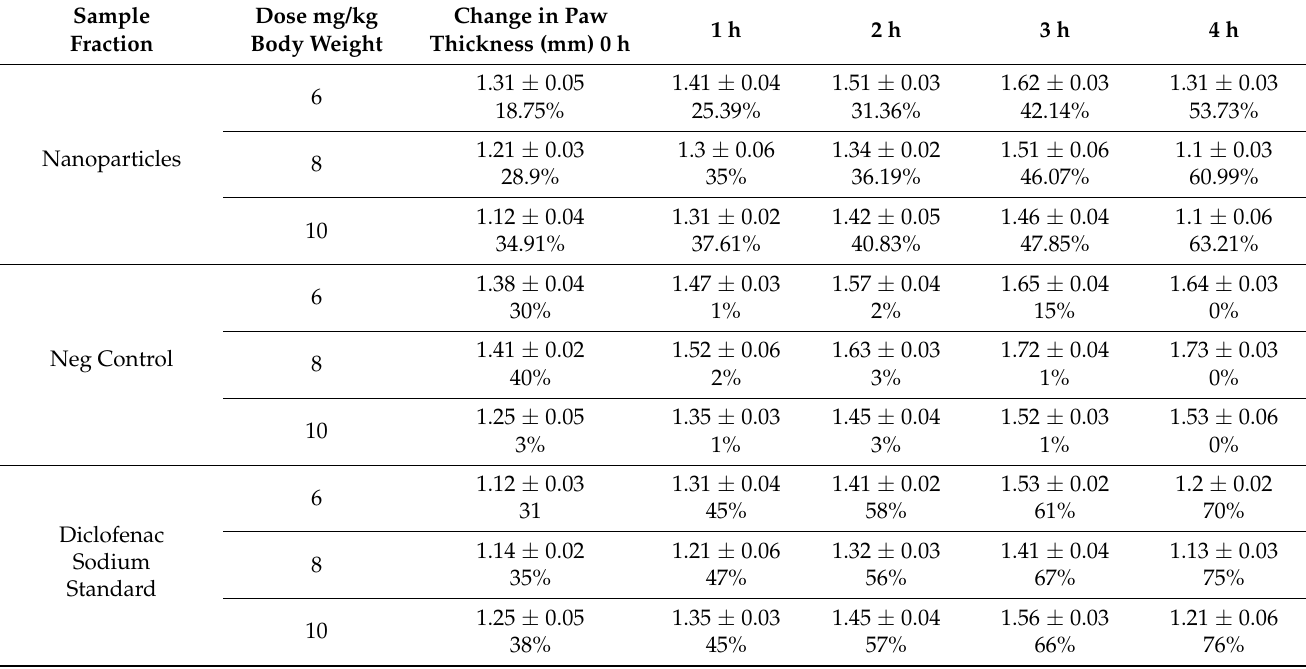
Table 7. In vivo anti-inflammatory effects of ZnO NPs of L. edodes aqueous fractions of methanolic extracts on carrageenan-induced